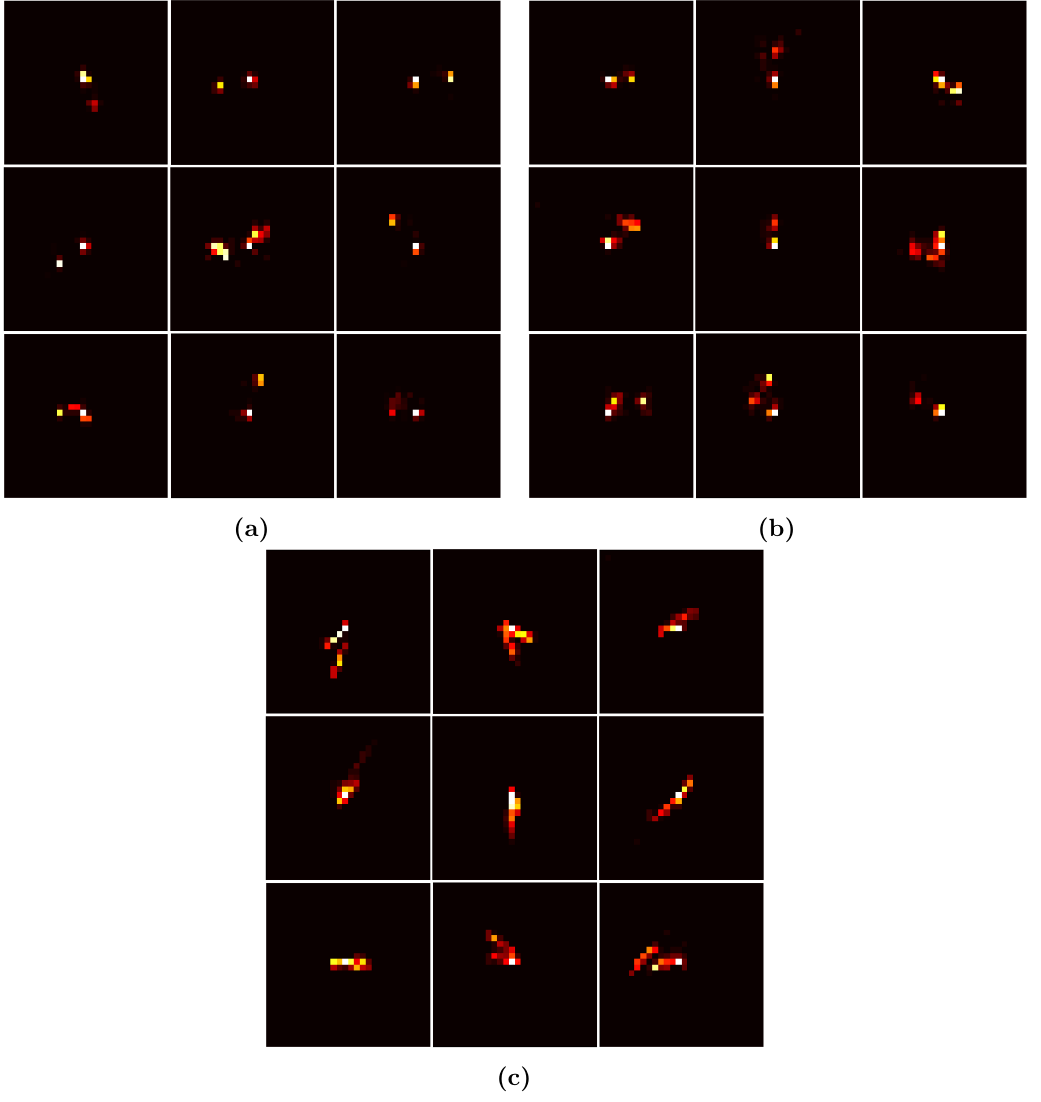
Figure 5. Typical energy deposition images of nine events from (a) non-displaced Z , (b) Z having a transverse displacement between 50 cm (cid:0) 70 cm and (c) Z having a transverse displacement between 200 cm (cid:0) 220 cm. With increasing displacement, energy deposition becomes more and more